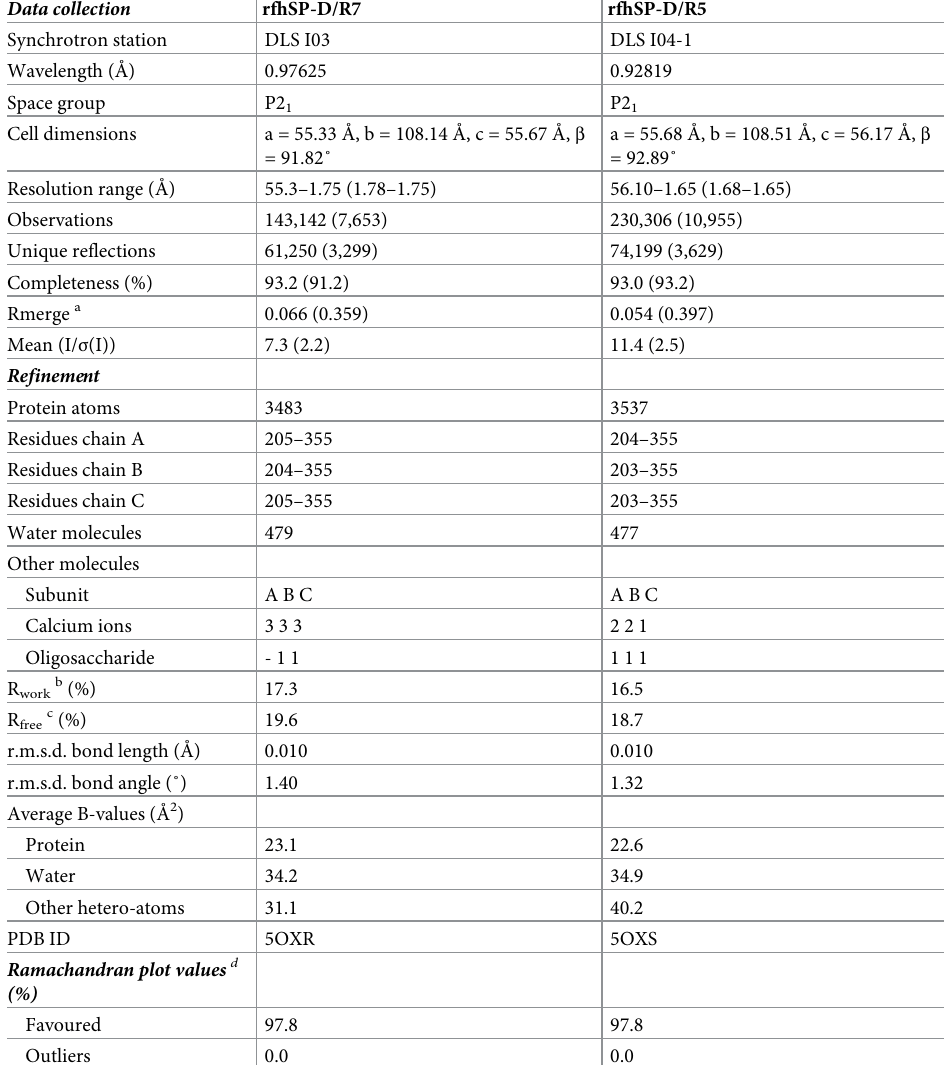
Table 1. Data collection and